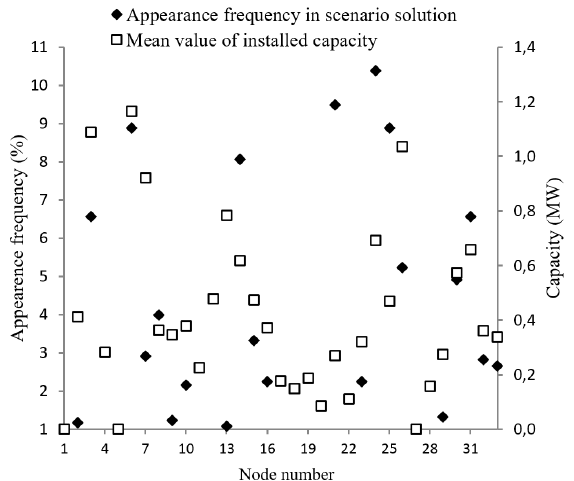
Figure 6. Sensitivity analysis regarding CF variations for 33 bus system.